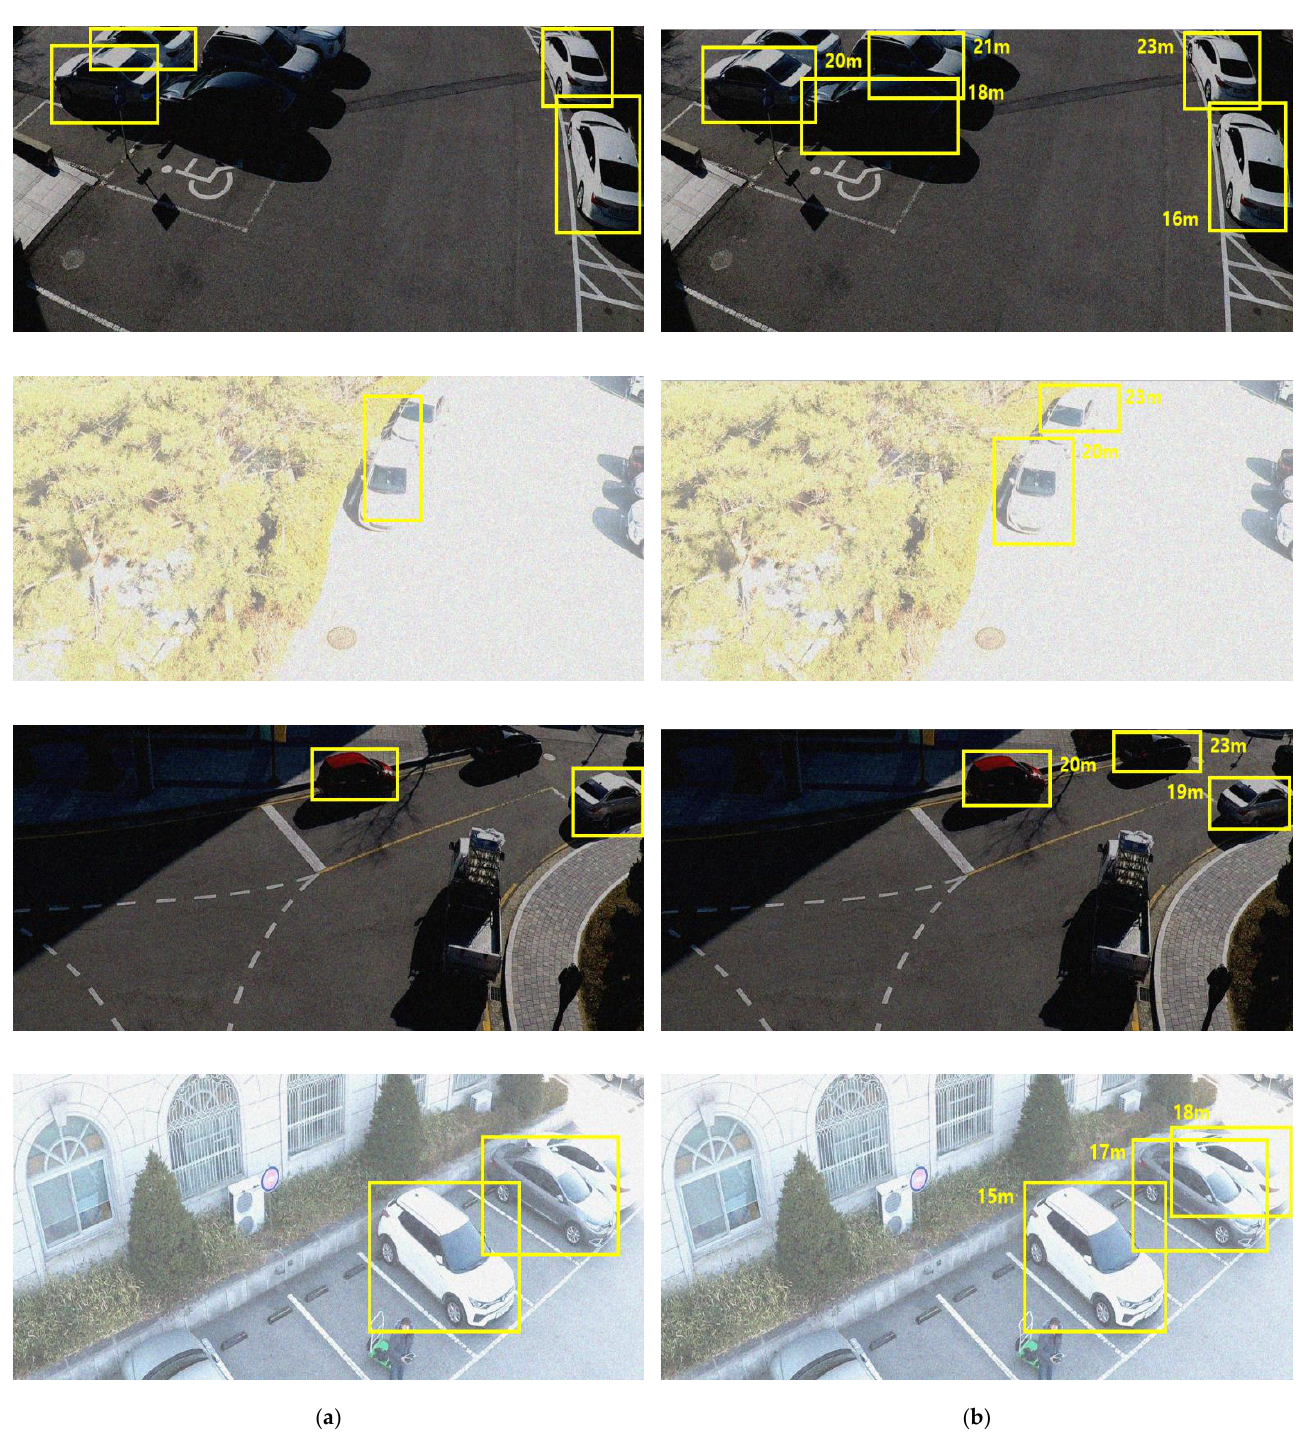
Figure 9. Comparison of vehicle detection results by vision-based faster R-CNN ( a ) and RGDiNet ( b ).